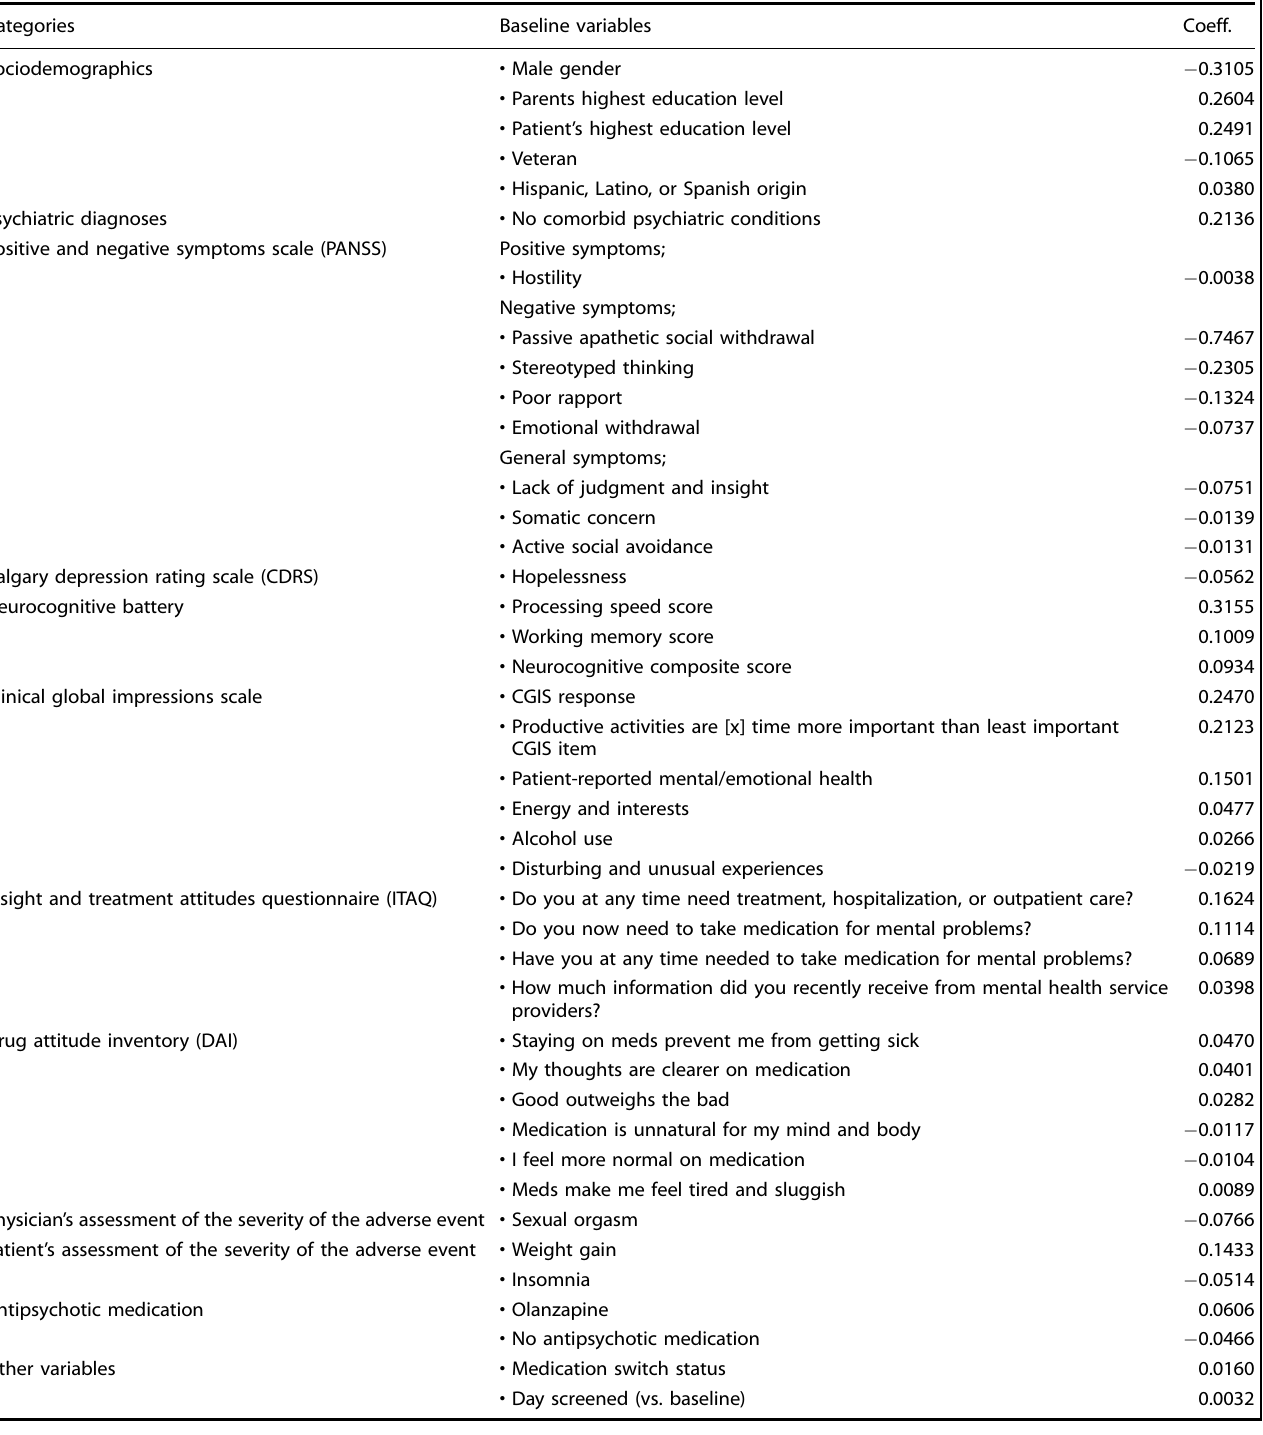
Table 4. Linear regression of QoL at the 6-month visit using baseline variables. N =